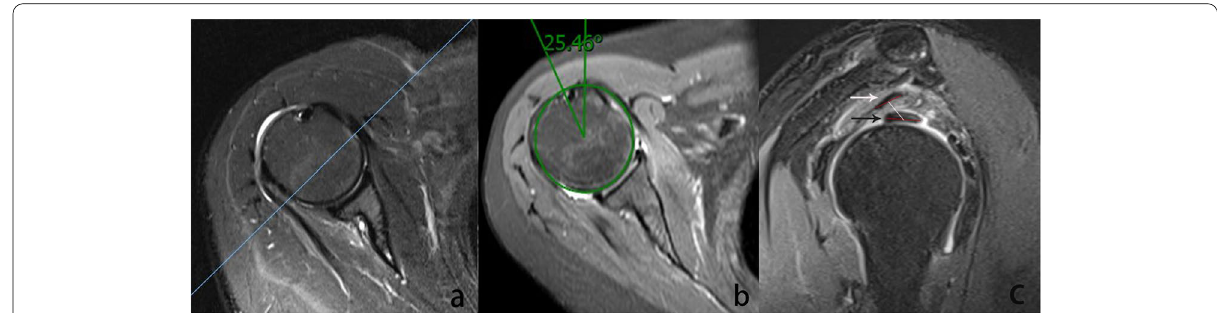
Fig. 1 a First, an oblique sagittal cross-section across the tip of coracoid process was selected (blue line). b On a horizontal plane, a proximal slice depicting the obvious outline of the bicipital groove was selected to measure the radius and rotation angle (green line). The angle formed by the line from the central point to the bicipital groove and the vertical line was defined as rotation angle. c The white arrow indicates the supraspinatus central tendon, and the black arrow indicates the long head of the biceps tendon. From the anterior edge to the posterior edge of each tendon two straight lines (red line) are drawn. Inter-tendon distance was defined as distance (white line) between the midpoints of the two straight lines